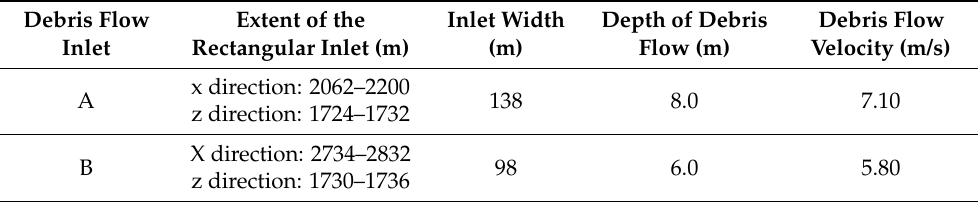
Table 2. Boundary conditions of numerical